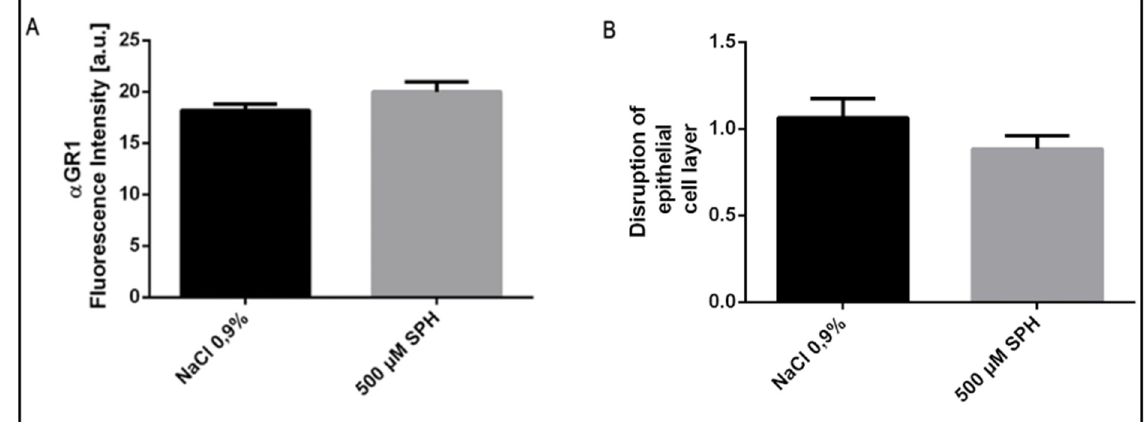
Fig 7. A and B: Quantitative analysis of histological studies from EVLP lungs stained with Cy3-coupled anti-Gr1-antibodies ( α GR1). (A) No significant difference in granulocytes and monocytes influx into the epithelial cell layer was observed. Quantitative analysis of the fluorescence intensity of a total of 1200 bronchial epithelial cells per group is displayed. Quantitative analysis of the disruption of epithelial cell layer (B) after inhalation of NaCl 0.9% or 500 μ M SPH. No significant differences in epithelial cell integrity using a grading model (Grade 0: no change of the epithelial cell layer, basal membrane intact, less than 2% pyknotic, i.e. dead epithelial cells. Grade 1: small disruptions of the epithelial cell layer, basal membrane intact, less than 5% pyknotic, i.e. dead epithelial cells; Grade 2: Larger disruptions of the epithelial cell layer, basal membrane still intact, less than 10% pyknotic, i.e. dead epithelial cells; Grade 3: Larger disruptions of the epithelial cell layer, disrupted basal membrane, more than 10% pyknotic, i.e. dead epithelial cells) were observed between the groups. Given is the mean ± SD of α GR1 Fluorescence intensity and disruption of epithelial cell layer from each 3 sections with analysis of fluorescence intensity in epithelial cells within 5 visual fields per animal (n = 4 for the control group and n = 5 for the sphingosine group), p < 0.05 was considered as significant; students t-test/ Mann-Whitney-u-test.